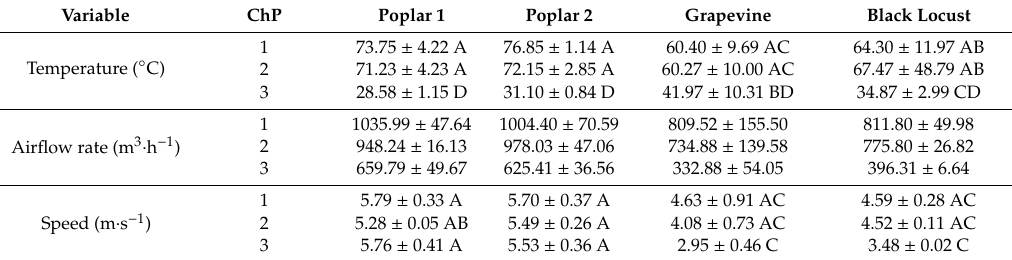
Table 4. Features of the airflow monitored during the drying test (mean ± SD). For each variable, di ff erent letters indicate a significant di ff erence at the level of P ≤ 0.01 after Tuckey’s HSD test. Variable ChP Poplar 1 Poplar